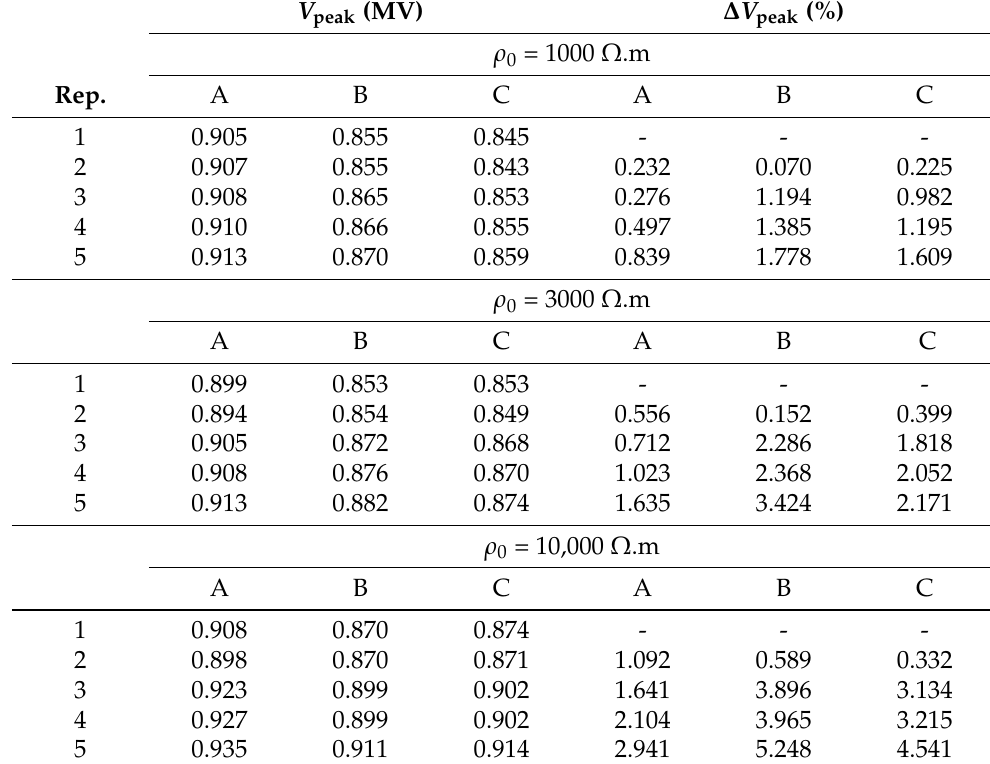
Table 4. Voltage peaks and ∆ V peak (%) for phases A, B and C, for the ρ 0 values (1000 Ω .m, 3000 Ω .m and 10,000 Ω .m), and considering the 5 types of modeling representations.